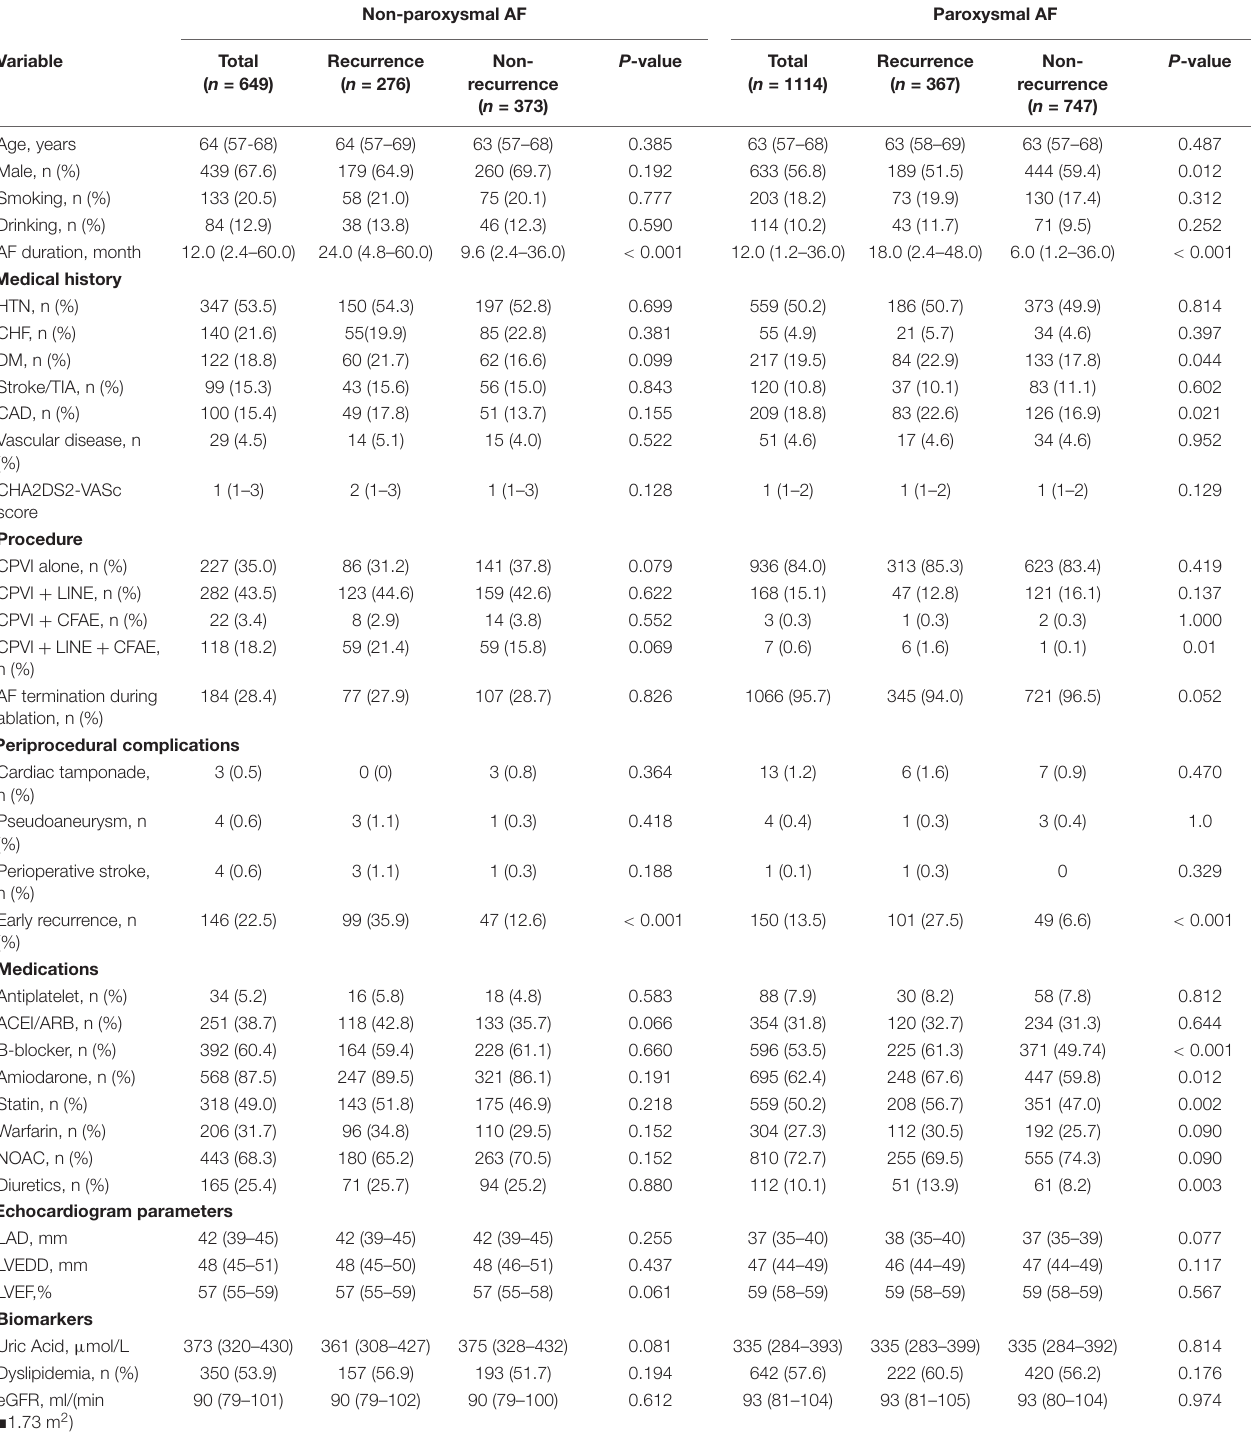
TABLE 1 | Baseline